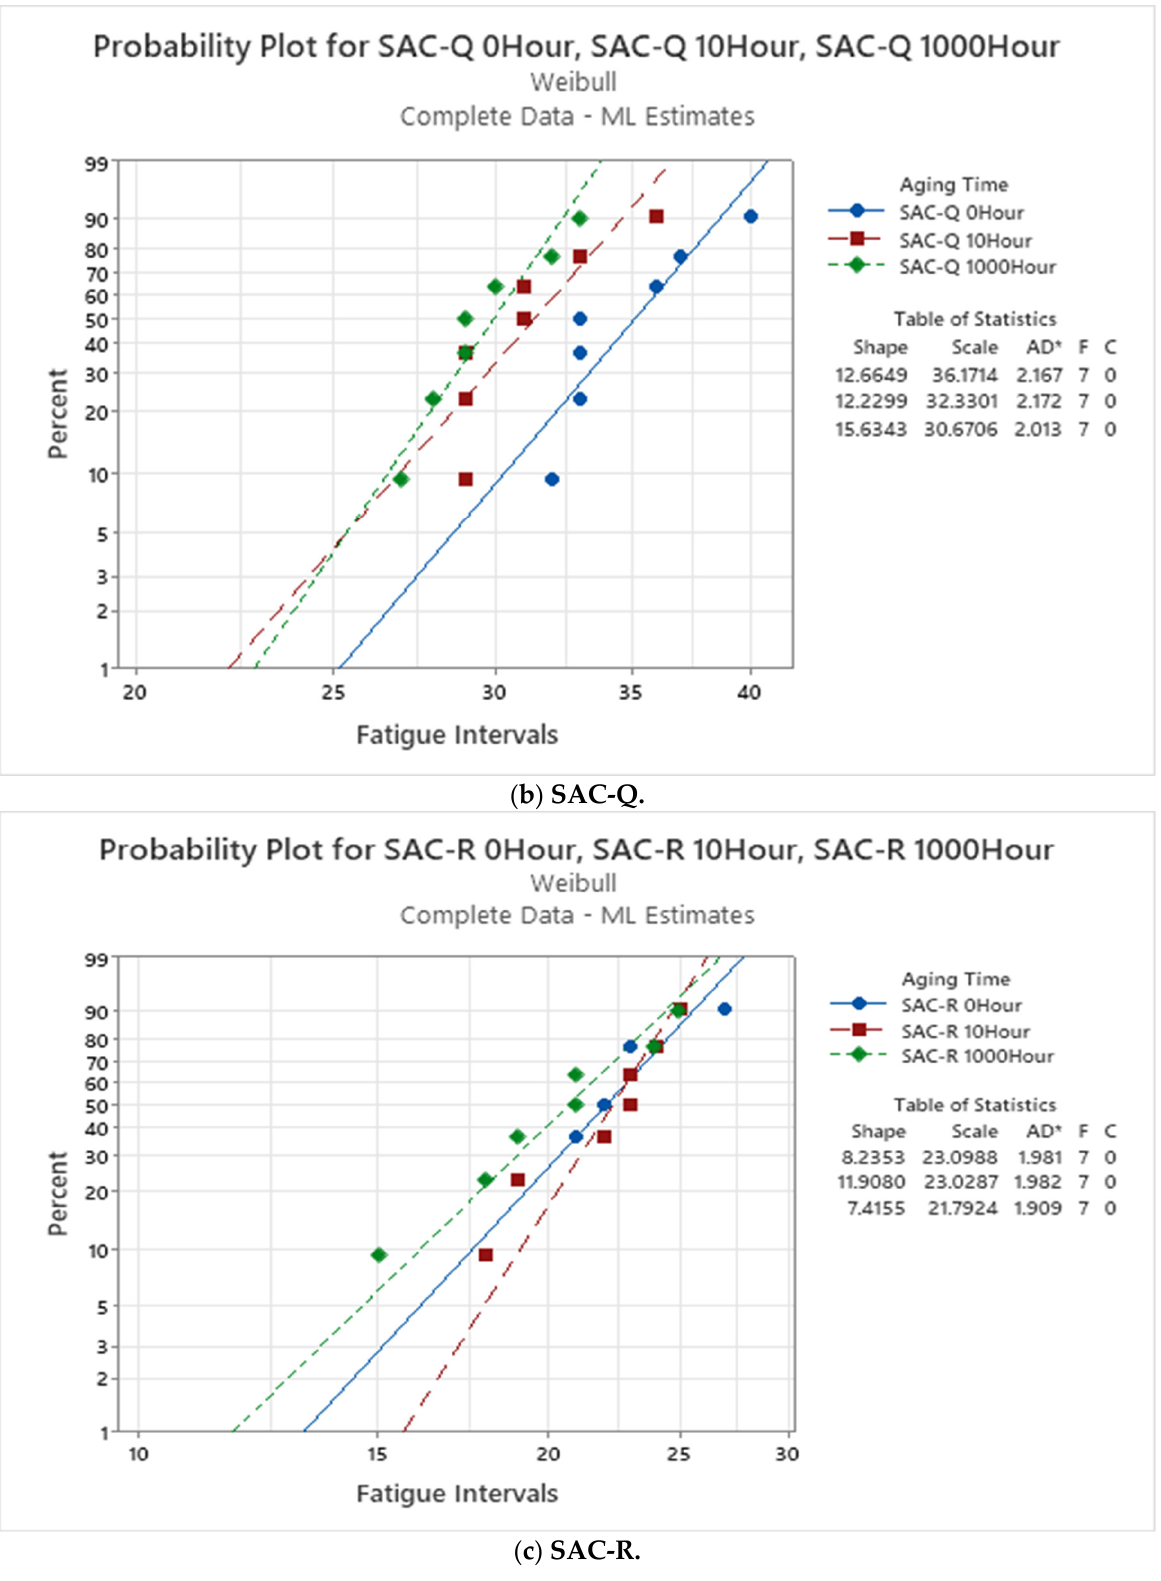
Figure 7. Fitted Weibull distribution and the characteristic fatigue life (intervals) of aged of ( a ) SAC 305; ( b ) SAC-Q; and ( c ) SAC-R in varying stress cycling.